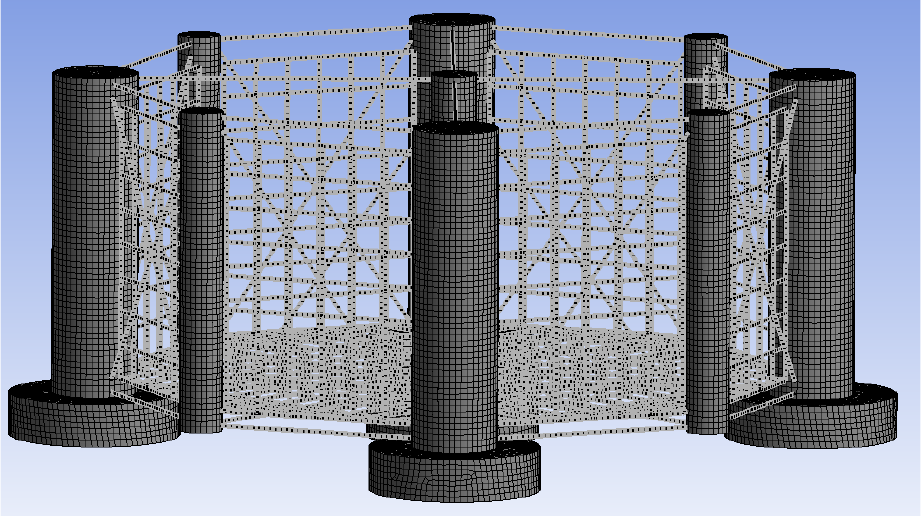
Figure 8. Panel model of the aquaculture cage in AQWA.